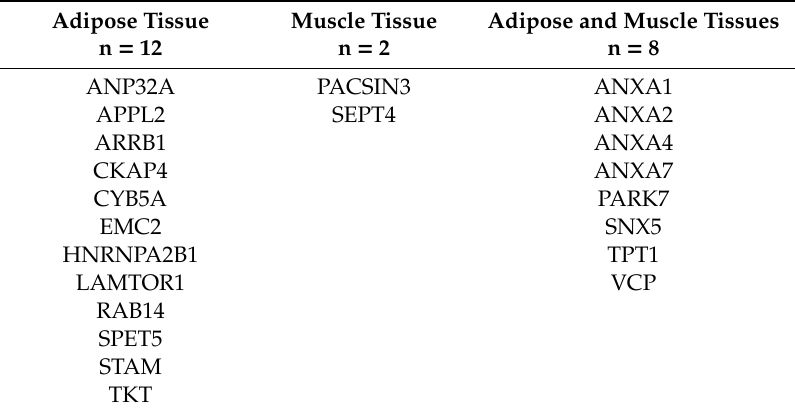
Table 2. Proteins potentially secreted by bovine fetal AT, muscle, or both tissues and by pathways that do not involve a signal peptide. The predictions were performed using the TargetP algorithm and were confirmed by the subcellular location provided by Uniprot and at least one GO term related to the secretion, as allowed by the ProteINSIDE webservice. Adipose Tissue Muscle Tissue Adipose and Muscle Tissues n = 12 n = 2 n = 8 ANP32A PACSIN3 ANXA1 APPL2 SEPT4 ANXA2